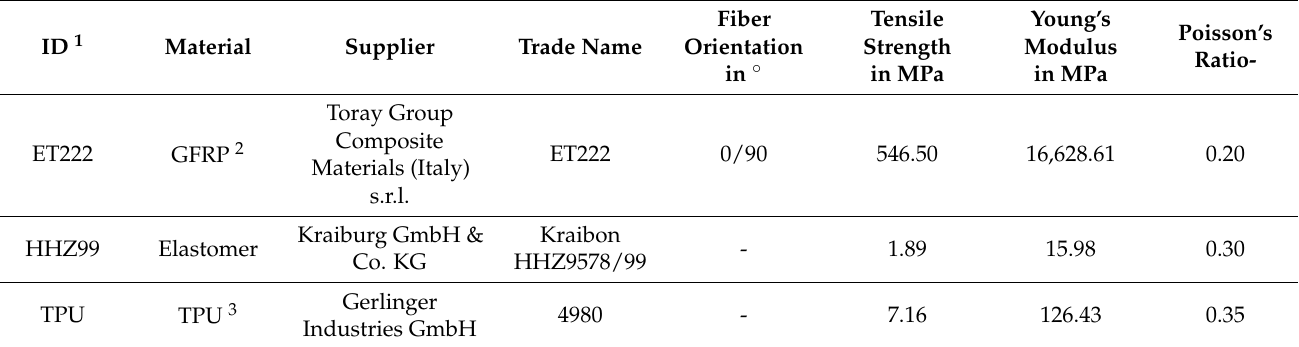
Table 1. Material properties [12].